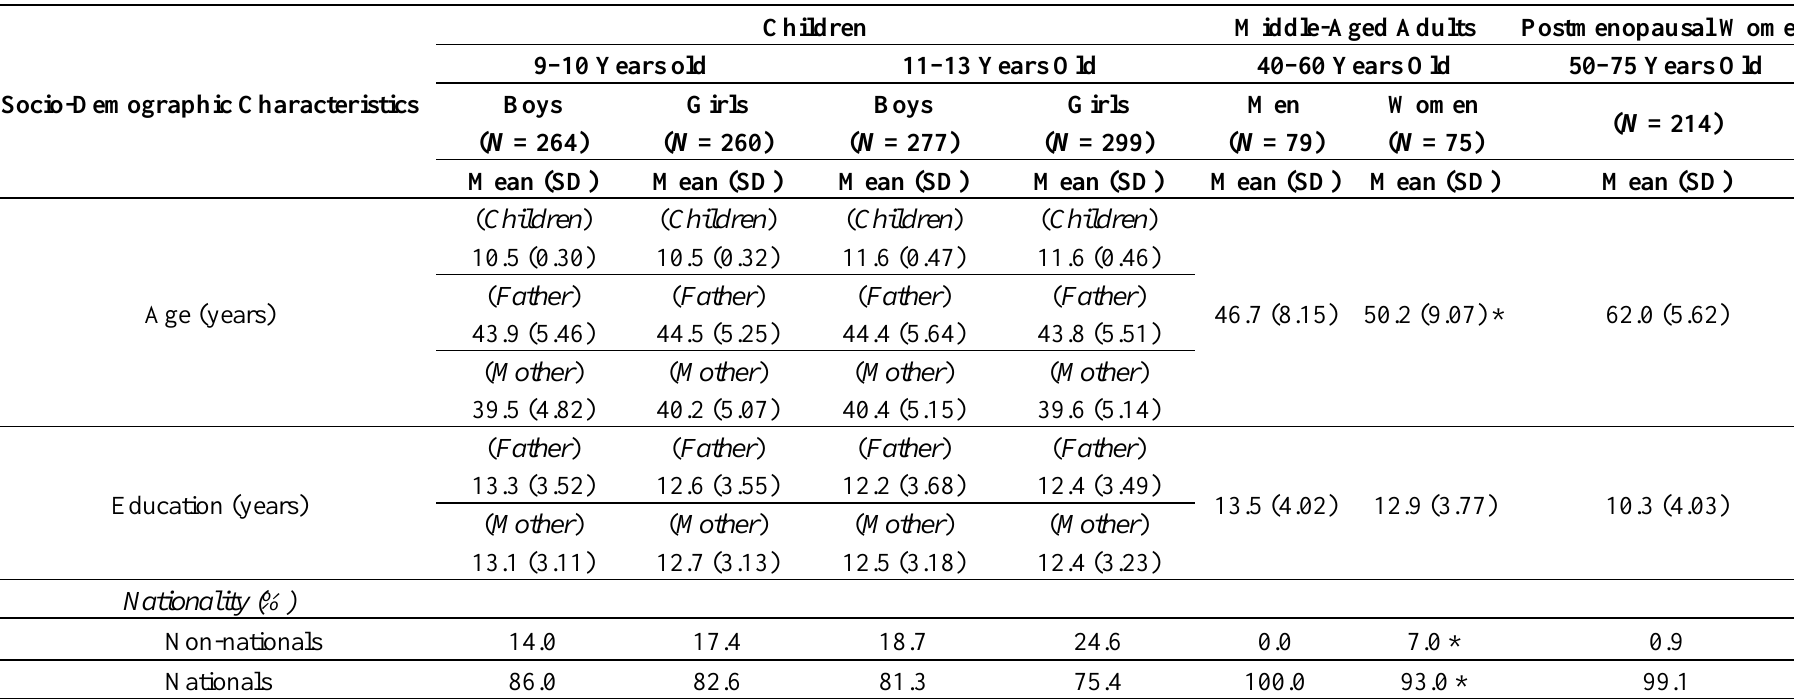
Table 1. Descriptive socio-demographic characteristics of children (and their parents), middle-aged adults and postmenopausal women.